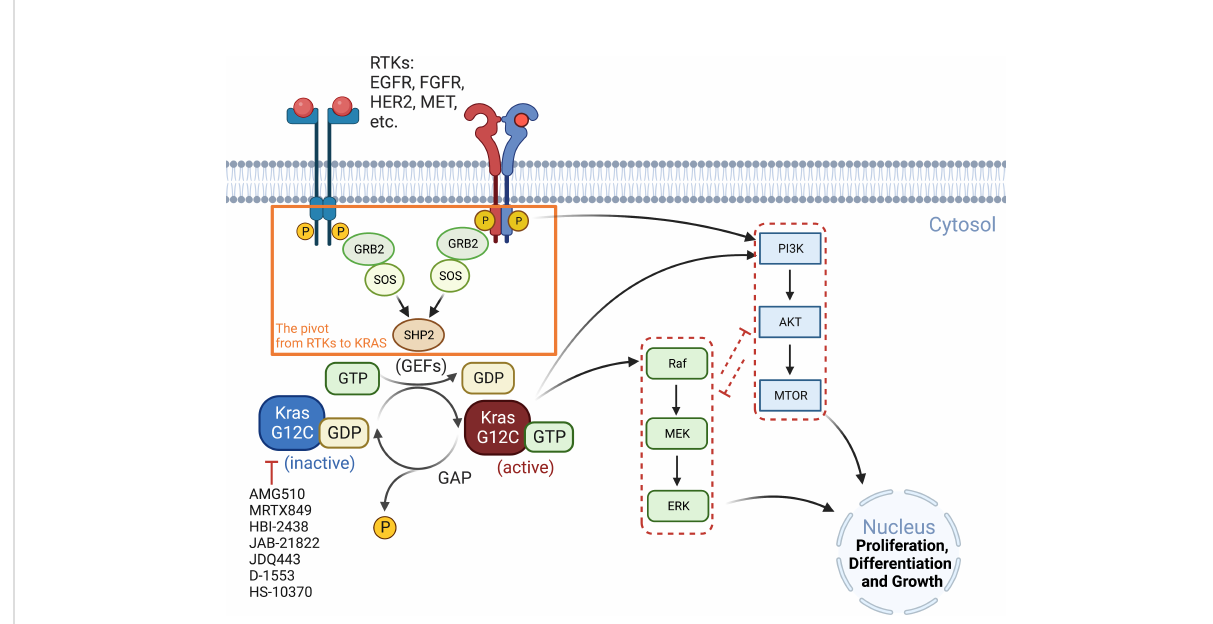
FIGURE 1 Oncogenic KRAS signaling pathway. KRAS switches between the GDP-bound inactive form and the GTP-bound active state, which is facilitated by GEFs and GAP, respectively. Activated RTKs relay extracellular signals from GRB2 to SOS, one of the major GEFs, to SHP2 and to KRAS. KRAS G12C inhibitors (AMG510, MRTX849, etc.) preferentially target the GDP-bound inactive form of the KRAS protein and prevent its conversion to the active form (GTP-bound). The major signaling cascades upstream and downstream of KRAS are also highlighted. GAP, GTPase-activating protein; GEFs, guanine nucleotide exchange factors; GRB2, growth factor receptor-bound protein 2; P, phosphorylation; SHP2, Src homology region 2 domain-containing phosphatase-2; SOS, son of sevenless